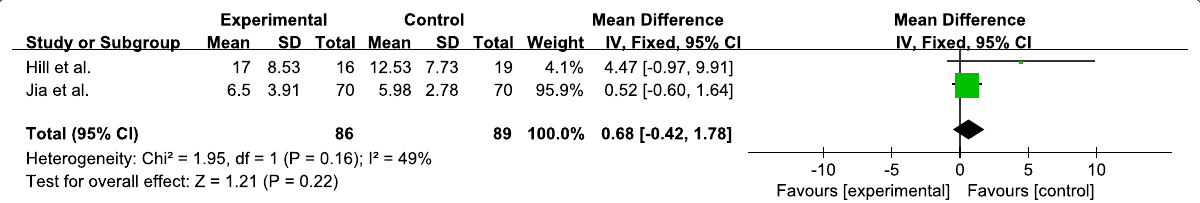
Fig. 2 Forest plot of the days to resolution (intent-to-treat analysis) between the experimental group and the control group